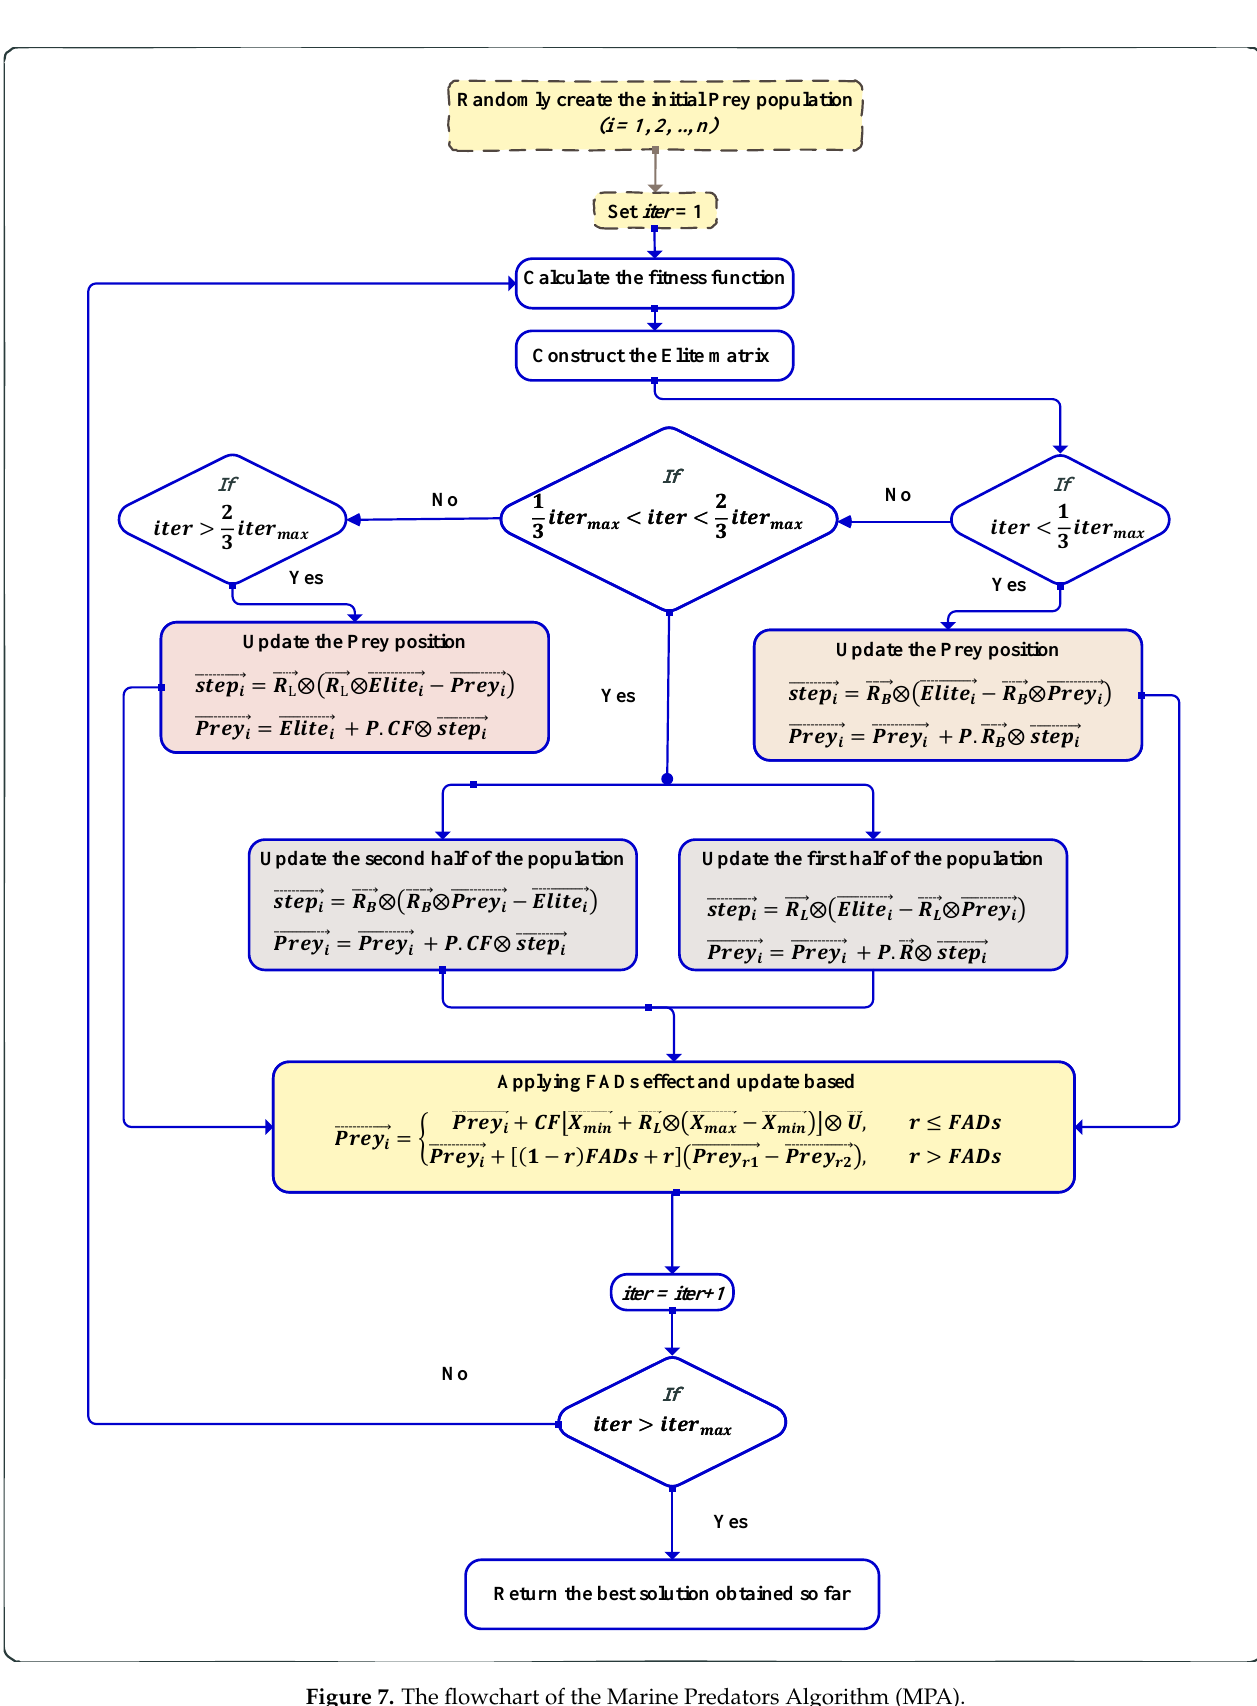
Figure 7. The flowchart of the Marine Predators Algorithm